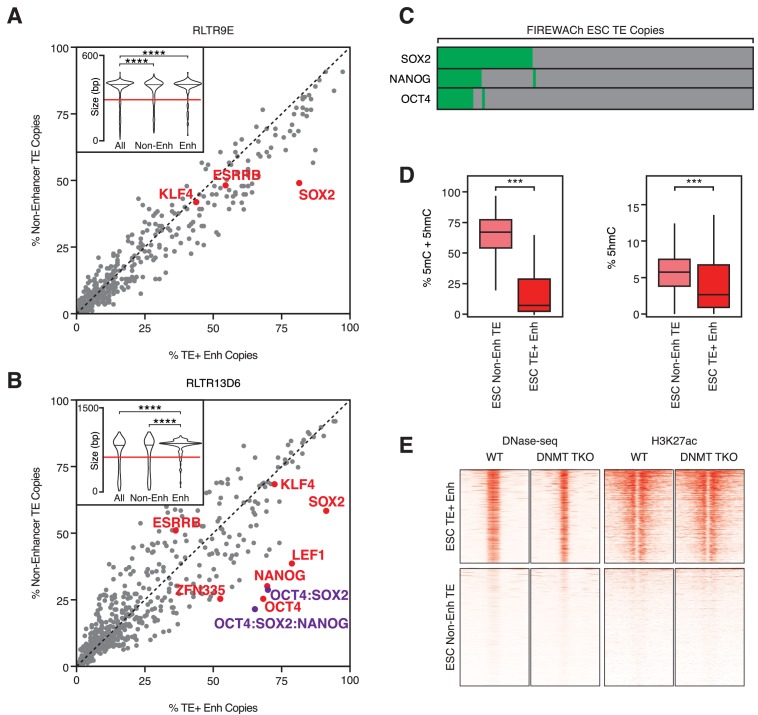
TF motifs do not predict TE enhancer potential.(A,B) Abundance of TF motifs at TE+ enhancers and non-enhancer TEs from RLTR9E (A) and RLTR13D6 (B) families. Purple data points refer to the co-occurrence of multiple TF motifs in the same element. Inset: length distribution of elements in each category (****p<0.0001, Kolmogorov-Smirnov test); only elements longer than 60% of the maximum length (red line) were used for motif analysis. (C) A minority of TE copies with enhancer activity in a reporter-based assay (FIREWACh) harbour SOX2, NANOG or OCT4 motifs, as indicated in green. (D) Analysis of BS-seq and TAB-seq data shows that non-enhancer TEs display higher levels of DNA methylation than TE+ enhancers and only moderately higher levels of hydroxymethylation (***p<1E-10, Wilcoxon test). (E) DNase-seq and H3K27ac ChIP-seq profiles of TE+ enhancers and non-enhancer TEs in wildtype and Dnmt TKO ESCs, showing similar profiles between both cell lines.